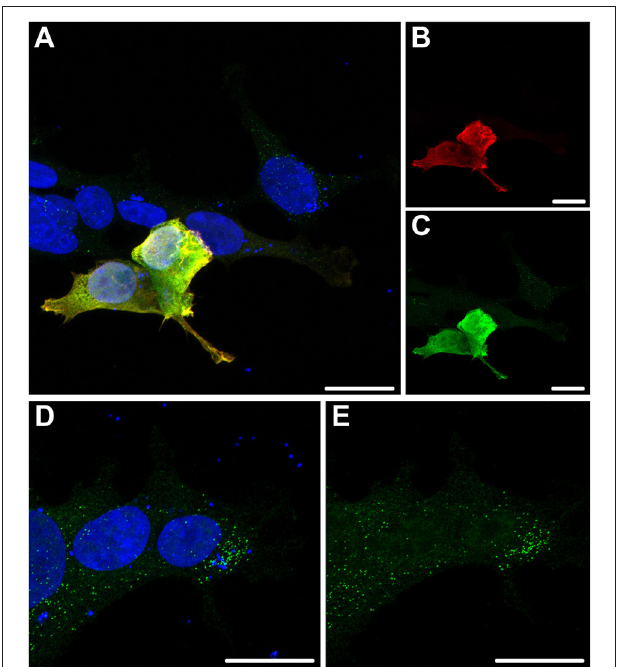
FIGURE 7 | Cytosolic spotted pattern of MORN5 expression in HEK293T cells. (A–C) HEK293T cells were transfected with FLAG-tagged MORN5-expressing vector and immunostained using both FLAG and MORN5 antibodies. Cells expressing transgenic MORN5 were also MORN5-positive pointing to the specificity of the antibody. (D,E) In addition, a cytosolic spotted pattern of MORN5 expression was present in non-transfected cells. Scale bars = 100 µ m.